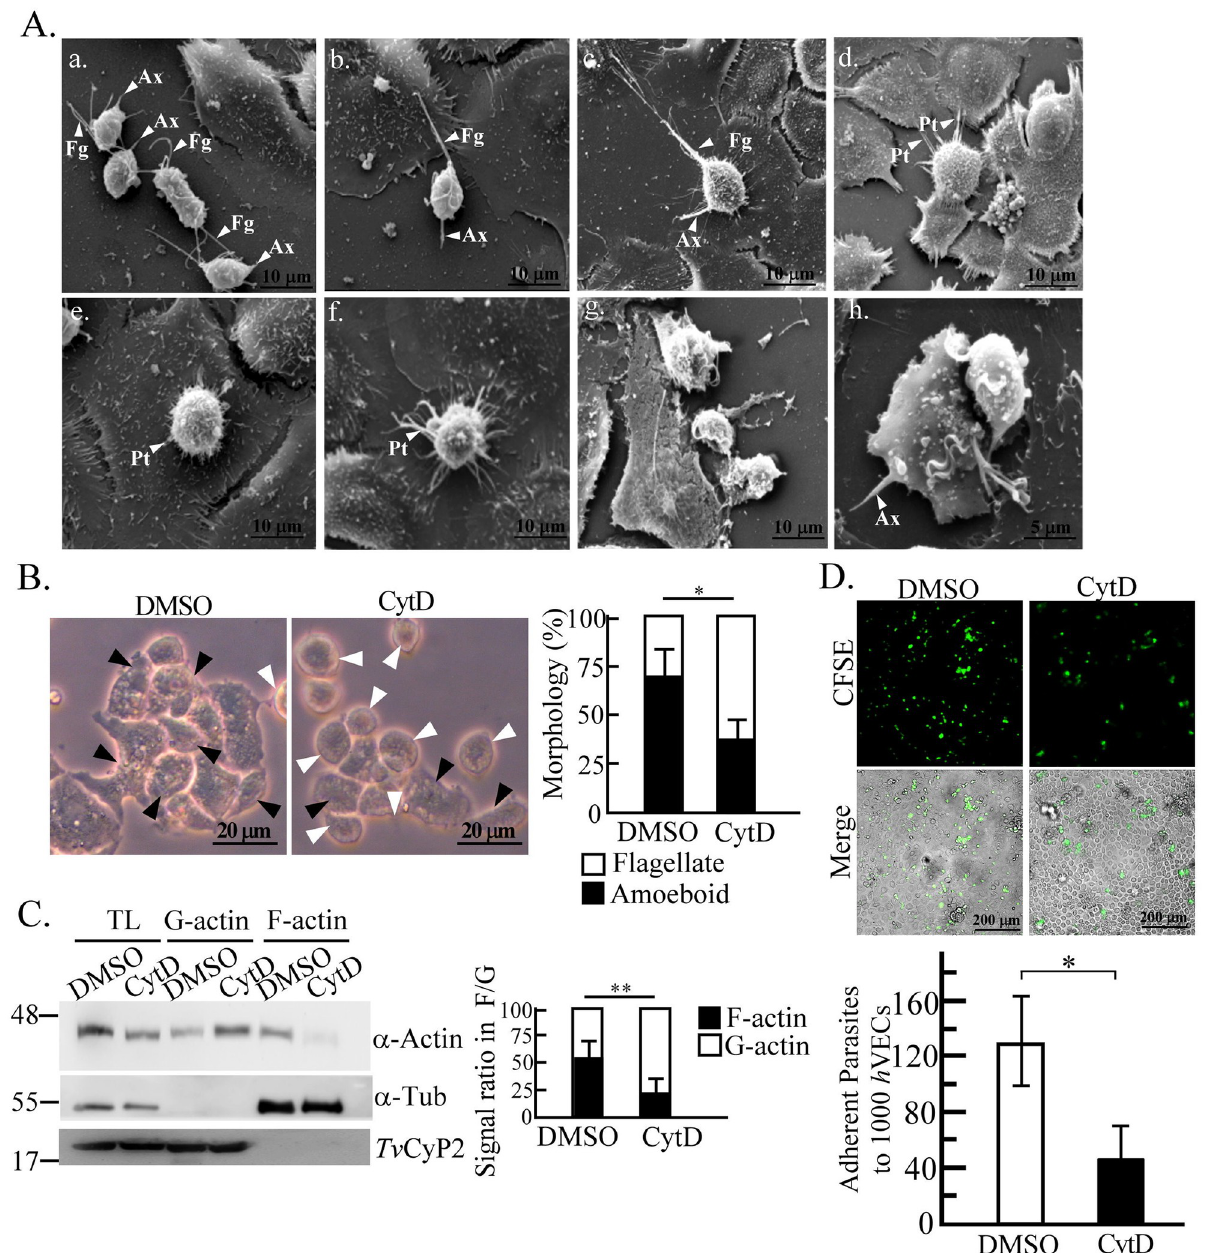
Fig 4. Morphological transformation of T . vaginalis on exposure to h VECs. A. TH17 trophozoites (a) were co-incubated with h VECs for 15 (b. and c.), 30 (d, e, f), or 60 min (g and h) for SEM. White triangles point to the flagellum (Fg), axostyle (Ax), or membrane protrusions (Pt). The representative morphology was observed from at least ~50 trophozoites at stages as specified in the infection course. B. The trophozoites treated with DMSO or CytD were cultured in T25 flasks for 1 hr and the morphology was monitored by phase-contrast microscopy. The black and white arrowheads respectively indicate the amoeboid and flagellate forms of T . vaginalis . The percentage of flagellate against amoeboid trophozoites was measured in 600 trophozoites within 6 microscopic fields as shown in the bar graph. C. TH17 trophozoites treated with DMSO or CytD were fractionated into F-actin and G-actin- containing fractions for western blotting. The ratio of the α -actin signal in G-actin versus F-actin was quantified as shown in the bar graph. α -Tubulin ( α -Tub) and Tv CyP2 were detected as the purity markers of F-actin and G-actin fractions, respectively. D. The trophozoites pretreated with DMSO or CytD were co-cultured with h VECs (moi 1:3) for 1 hr in cytoadherence binding assay. The number of trophozoites bound per 1000 h VECs was measured as shown in the bar graph (mean ± SD). All experiments were repeated three times. Significant differences were statistically analyzed by the Student’s t-tests, with P < 0.01( �� ) and P < 0.05( � ).